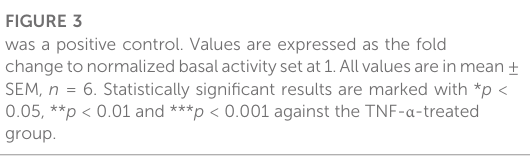
FIGURE 3 was a positive control. Values are expressed as the fold changetonormalizedbasalactivitysetat1.Allvaluesareinmean± SEM, n = 6. Statistically signi fi cant results are marked with * p < 0.05, ** p < 0.01 and *** p < 0.001 against the TNF- α -treated